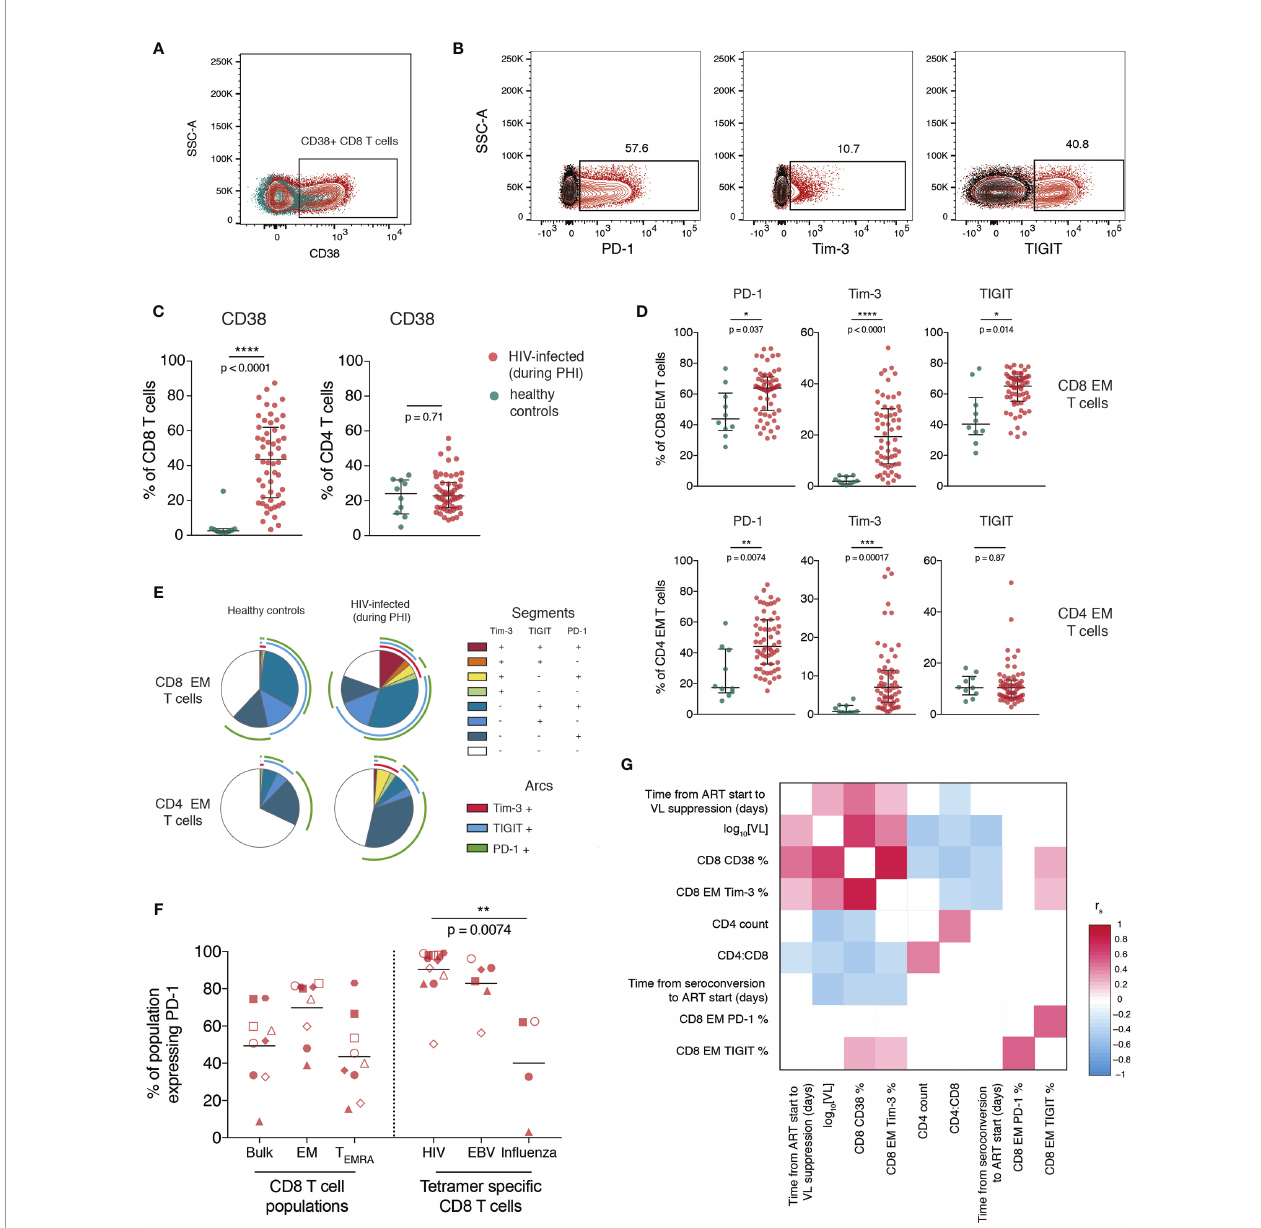
FIGURE 2 | T cell activation and increased immune checkpoint receptor expression during primary HIV infection relates to measures of disease progression. (A) Representative staining of CD38 on CD8 T cells; plot shows one individual during PHI (red) overlaid over healthy control (green). (B) Representative gating of PD- 1, Tim-3 and TIGIT; plots are gated on CD8 EM cells and show staining from one individual during PHI (red) overlaid over gating control (black) (C) Expression of CD38 on CD8 and CD4 T cells (n = 54 PHI, red; n = 10 healthy, green). Groups were compared using a Mann-Whitney test. (D) The expression of PD-1, Tim-3 and TIGIT on EM CD8 and CD4 T cells is compared between PHI (n = 60, red) and healthy control (n = 10, green). Expression was compared on all memory subsets using Mann-Whitney tests (complete data shown in Figure S5 ) and adjustment of p-values for multiple comparisons was performed to control the false discovery rate. Asterisks and listed p-values correspond to the adjusted p-value. (E) Co-expression of PD-1, Tim-3 and TIGIT on CD8 and CD4 EM cells from healthy controls and during PHI. Each segment represents the proportion of cells (median) with a different co-expression combination; arcs indicate which markers are in that combination. (F) PD-1 expression on bulk CD8 T cell populations, as well as tetramer speci fi c CD8 T cells. Tetramer speci fi c CD8 T cells were compared using a Kruskal-Wallis test (overall p = 0.0088) with subsequent pairwise comparisons using Dunn ’ s test. Symbol shapes indicate tetramers from the same individual. EBV and in fl uenza tetramers were not available for all individuals; for some individuals multiple different HIV tetramers were used and these are shown as separate data points. (G) Correlations between CD8 EM expression of PD-1, Tim-3 and TIGIT during primary HIV infection and clinical measures of disease progression. The colour of each block corresponds to the correlation coef fi cient between any two variables. Variables have been ordered using hierarchical clustering. Correlation coef fi cients were calculated using the Spearman method with pairwise complete observations; only correlations signi fi cant at a p = 0.05 level are shown (other boxes are left blank). For all panels, bars indicate median and interquartile range. * indicates p < 0.05; ** indicates p < 0.01; *** indicates p < 0.001, **** indicates p <